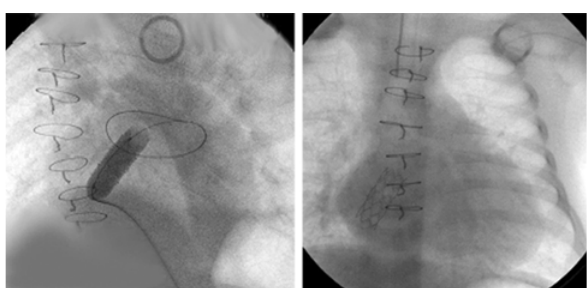
Fig. 5 - Implante do stent pré-montado Palmaz Genesis (6 X 19 mm) na comunicação